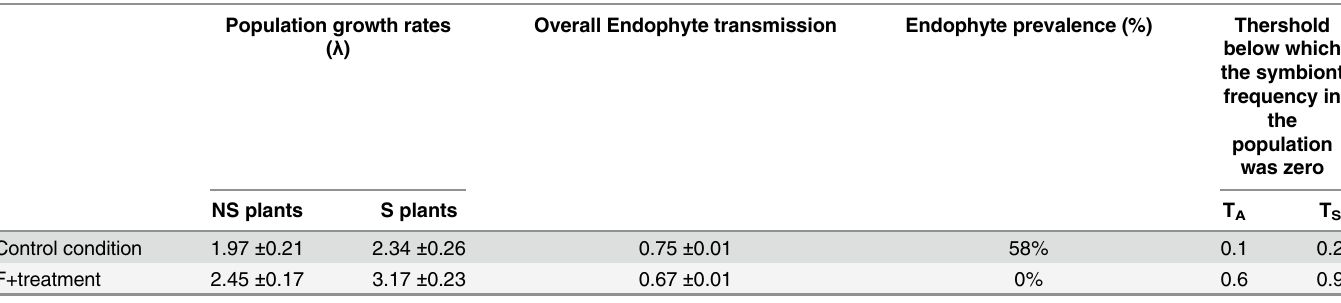
natural conditions (Table 4: NS: 1.18±0.025 vs. S: 1.44± 0.051, p < 2.2e-16). Similarly, S plants Table 3. Summary of endophyte effect, transmission rates and prevalence values in F . eskia under two resource levels. Growth rates were obtained from the model A, the overall endophyte transmission were measured in the field, the endophyte prevalence were returned by the model B and the threshold in transmission below which the symbiont frequency in the population was zero were obtained by simulations. T A transmission rate from adult to seed, T S transmission rate from seedling to